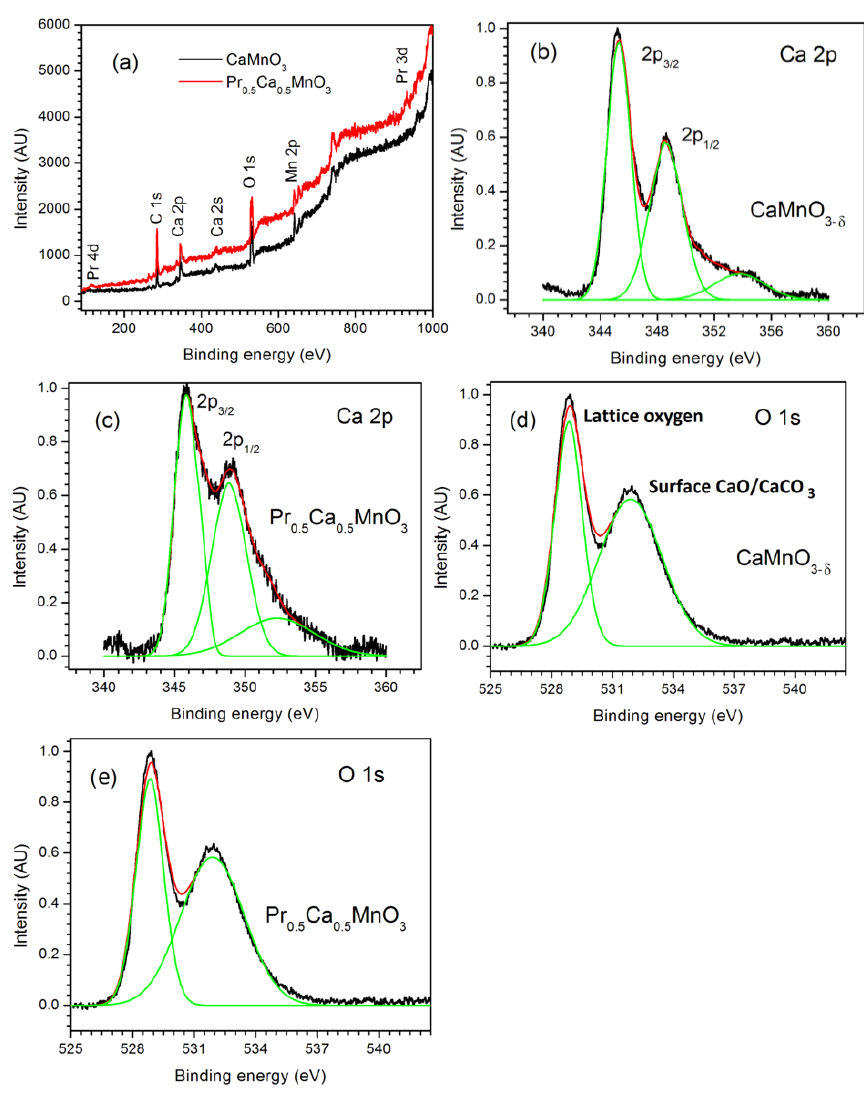
Figure 4. XPS survey spectra ( a ), Ca 2p ( b , c ), and O 1s ( d , e ) photoemission spectra of CaMnO 3- δ and Pr 0.5 Ca 0.5 MnO 3 taken in normal emission using an Al K α X-ray source. The peaks in the O 1s region were assigned to lattice oxygen and surface hydroxyl groups, carbonyl groups, and CaO/CaCO 3 .